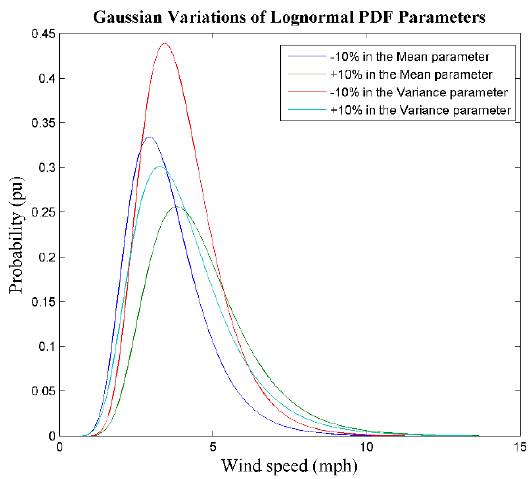
Figure 14. Wind speed probabilities due to variations in the µ and σ parameters of the wind speed Lognormal PDF.